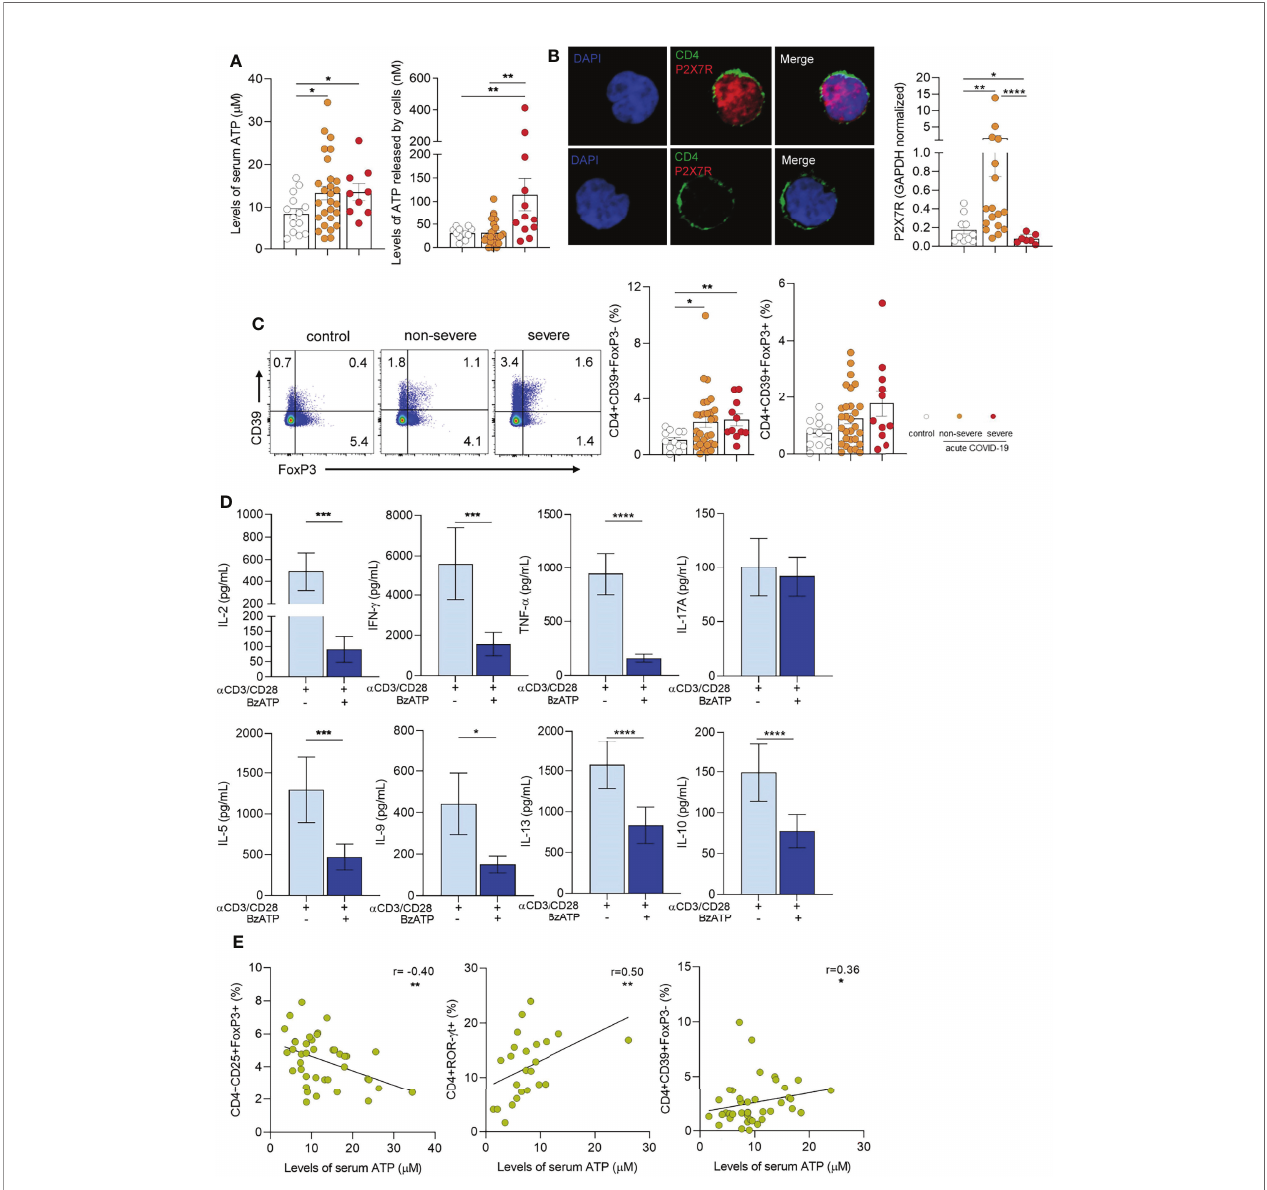
FIGURE 2 | Extracellular ATP-P2X7R axis in children with COVID-19. (A) Left panel: Levels of ATP in plasma from healthy children (controls, n = 14), and children with COVID-19 (non-severe, n = 27 and severe, n = 9) measured by luminometry. Right panel: PBMCs ( 5x10 6 /mL) from healthy children (controls, n = 12), and children with COVID-19 (non-severe, n = 25 and severe, n = 12) were stimulated with anti-CD2/CD3/CD28 coated beads (0.3 µg/mL) during 4 min. Levels of extracellular ATP were measured in the supernatant by luminometry. (B) Left panel: Confocal microscopy of P2X7R expression in puri fi ed CD4+ T cells (green: CD4, red: P2X7R). Nuclear counterstain with DAPI was used. Representative images from a child with non-severe COVID-19 are shown at x300. Right panel: Basal P2X7R expression in PBMCs from healthy children (controls, n = 10) and children with COVID-19 (non-severe, n = 17 and severe, n = 7) quanti fi ed by qRT-PCR. (C) Left panel: Representative dot plot showing the expression of FoxP3 and CD39 in CD4+ T cells of heathy children and children with COVID-19 (non-severe and severe). Middle and Right panels: Frequency of CD4+CD39+FoxP3- T cells (middle) and CD4+CD39+FoxP3+ T cells (right) in healthy children (n = 12), and children with COVID-19 (non-severe, n = 29 and severe, n = 11). Data are expressed as percentage of CD4+ T cells. (D) Puri fi ed CD4+ T cells (1×10 6 /mL) from children with COVID-19 (n = 15) were stimulated with anti-CD2/CD3/CD28 coated beads (0.035 µg/mL) and treated or not with BzATP (100 µM) during 3 days. Levels of cytokines were quanti fi ed in the culture supernatant by multiplex fl ow cytometric bead array. (E) Graphs showing correlations between the frequency of CD4+CD25+FoxP3+ Tregs (n = 40, left), CD4+ROR- g t+ T cells (n = 24, middle), and CD4+CD39+FoxP3- T cells (n = 40, right) and the levels of ATP in plasma. Mean ± SEM of n donors are shown in (A, B) (right), (C) (middle and right) and (D) P values were determined by Mann-Whitney U test, Kruskal-Wallis test and Wilcoxon test. Correlations were evaluated by using Spearman rank correlation coef fi cient test. *p<0.05, **p < 0.01, ***p < 0.001, ****p <